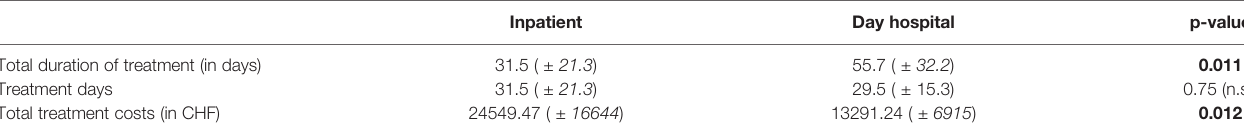
TABLE 8 | Total duration of treatment: days between admission and discharge, treatment days, and total treatment costs (in CHF), mean scores (± standard deviation , p -values (t tests, inpatient versus day hospital).